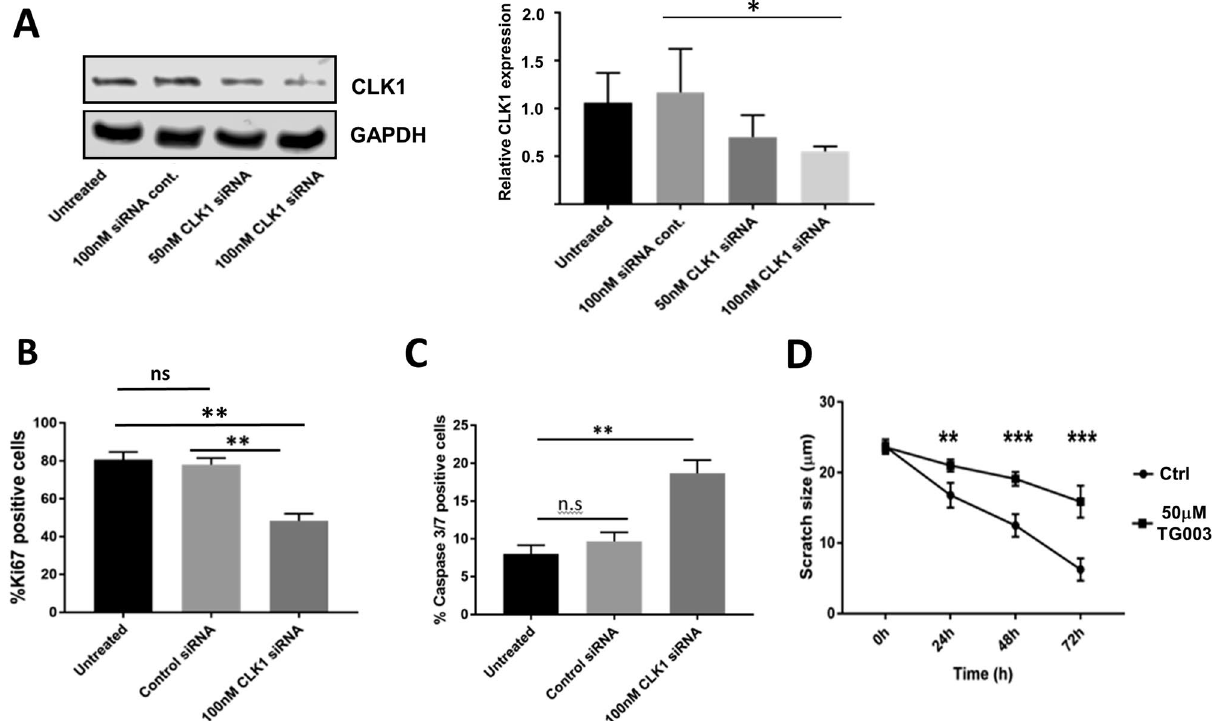
Figure 3. CLK1 knockdown confirms the effect of TG003. (A ) siRNA directed against CLK1 was transfected into PC3 cells. CLK1 and GAPDH signals are shown. The knockdown was quantified from N = 3 repeats (right panel). The effect of CLK1 knockdown was determined on cell proliferation via Ki67 staining ( B ); apoptosis with caspase 3/7 staining ( C ) and on scratch closure ( D ). N = 3 repeats in all experiments. ns, p > 0.05; * p < 0.05; ** p < 0.01; *** p <